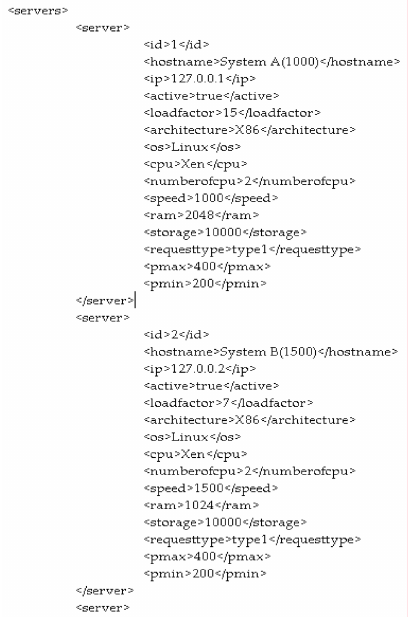
Figure 7. Servers specification in XML File.